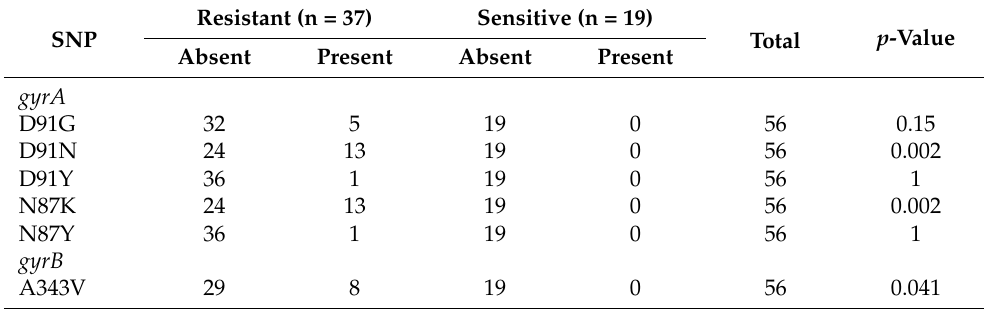
Table 1. Mutations associated with levofloxacin resistance in H. pylori .